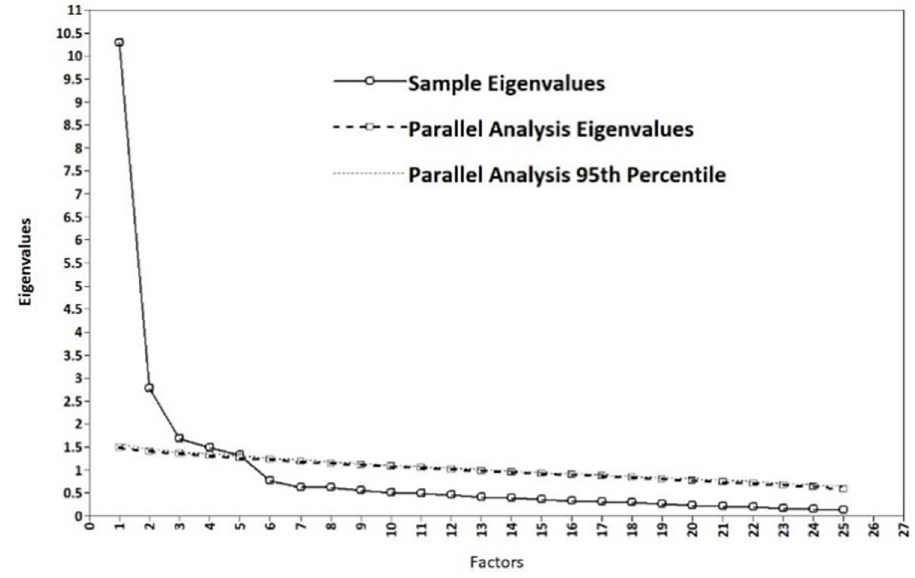
Fig 1. Scree plot and parallel analysis